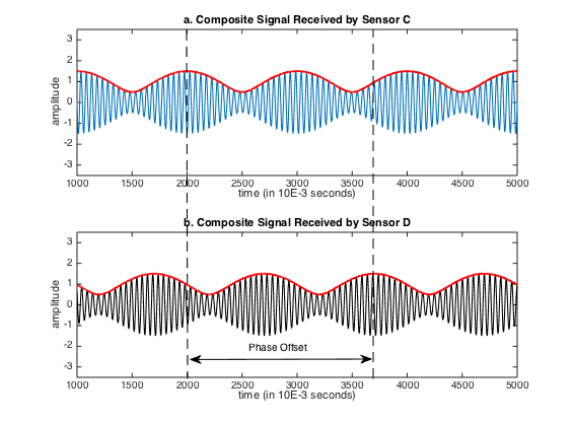
Fig. 1. Phase Offset Calculation with Time